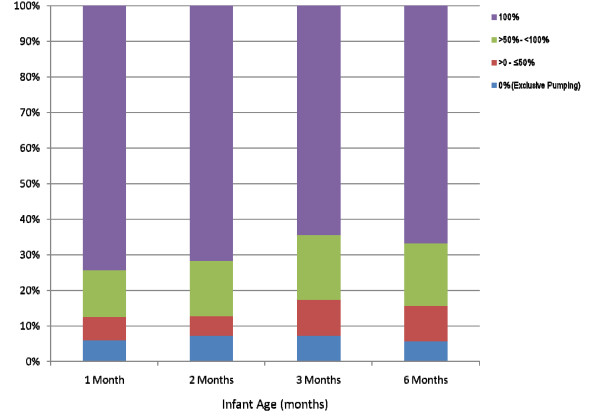
The proportion of breast milk feedings given directly at the breast over the first 6 months of life. Sample sizes were as follows: 1 month, n = 791; 2 months, n = 561; 3 months, n = 467, 6 months, n = 330.